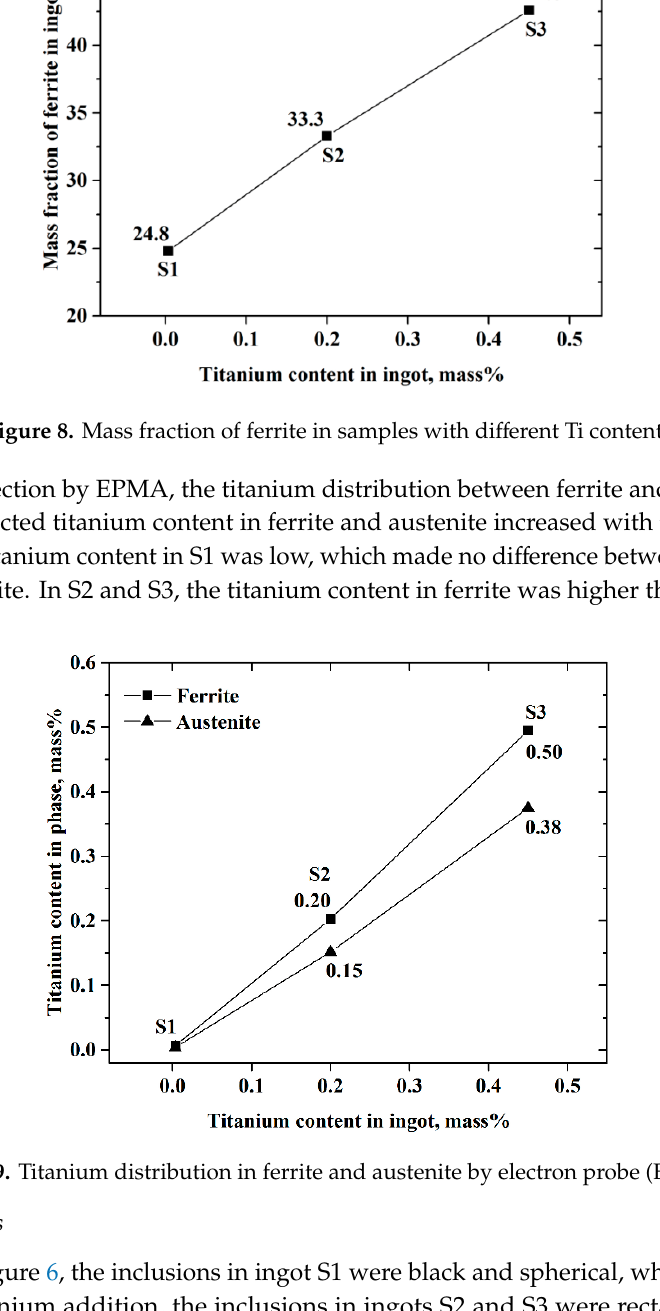
Figure 7. Element mapping of ferrite and austenite by energy dispersive spectroscopy (EDS) (online version in color).